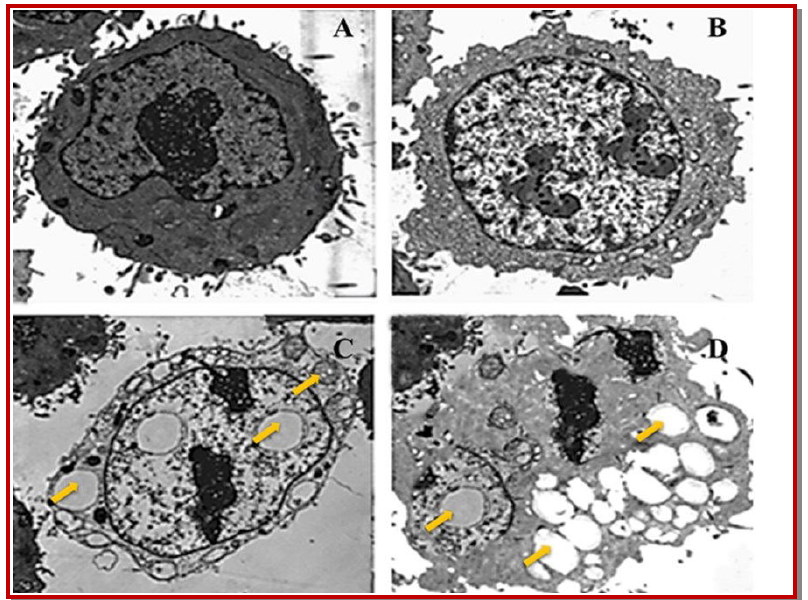
Figure 5: Ultrastructural examination of HL-60 human leukemia cancer cells using transmission electron microscopy (TEM). Un- treated control cells (A) exhibited normal cell morphology including normal nuclei, cytoplasm and cell organelles. Lactucin- treated cells (B, C and C represent 5, 50 and 100 µM dose of lactucin) indicated the appearance of autophagic vacuoles characteris- tic of autophagy process. The number and size of these autophagic vacuoles increased with increasing lactucin-dose, arrows repre- sent vacuoles. Magnification